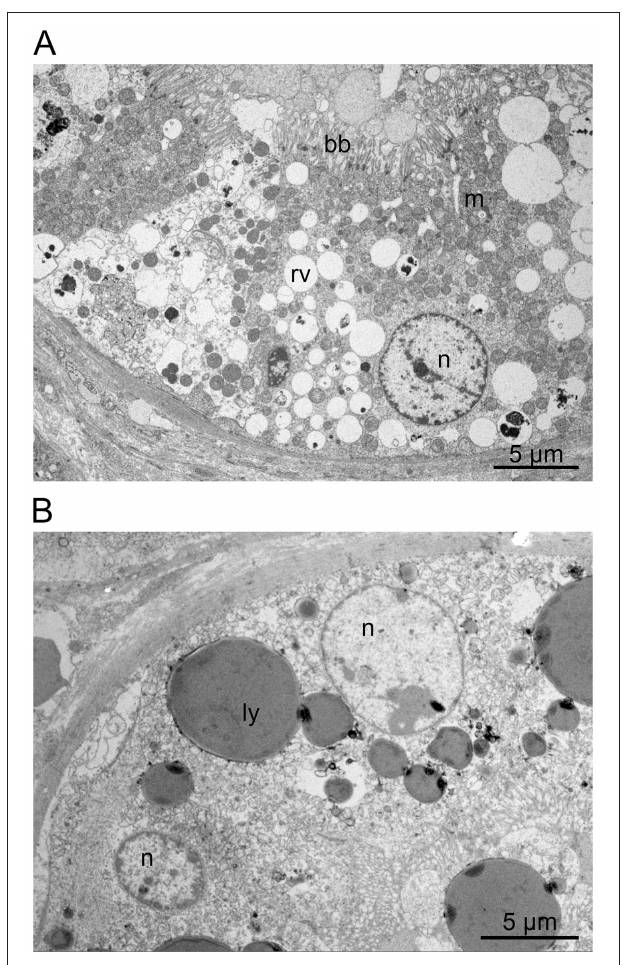
FIGURE 2 | (A,B) HES histology. Renal transmission electron microscopy: Besides rounded, euchromatin-rich nuclei (n), the proximal tubule cells showed a typical brush border (bb) and numerous mitochondria (m). The cells also displayed an extensive endocytic-lysosomal apparatus with variable amounts of resorptive vacuoles (rv) and large spherical lysosomes (ly) containing homogeneous, electron-dense material. A similar endocytic apparatus was also noted in the distal tubules (not